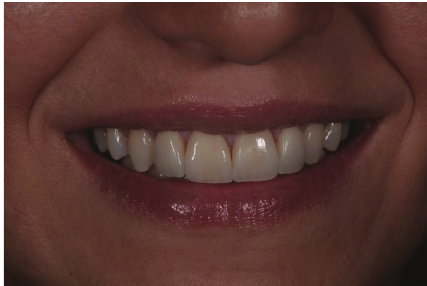
Figure 9: Final result: intraoral photography.